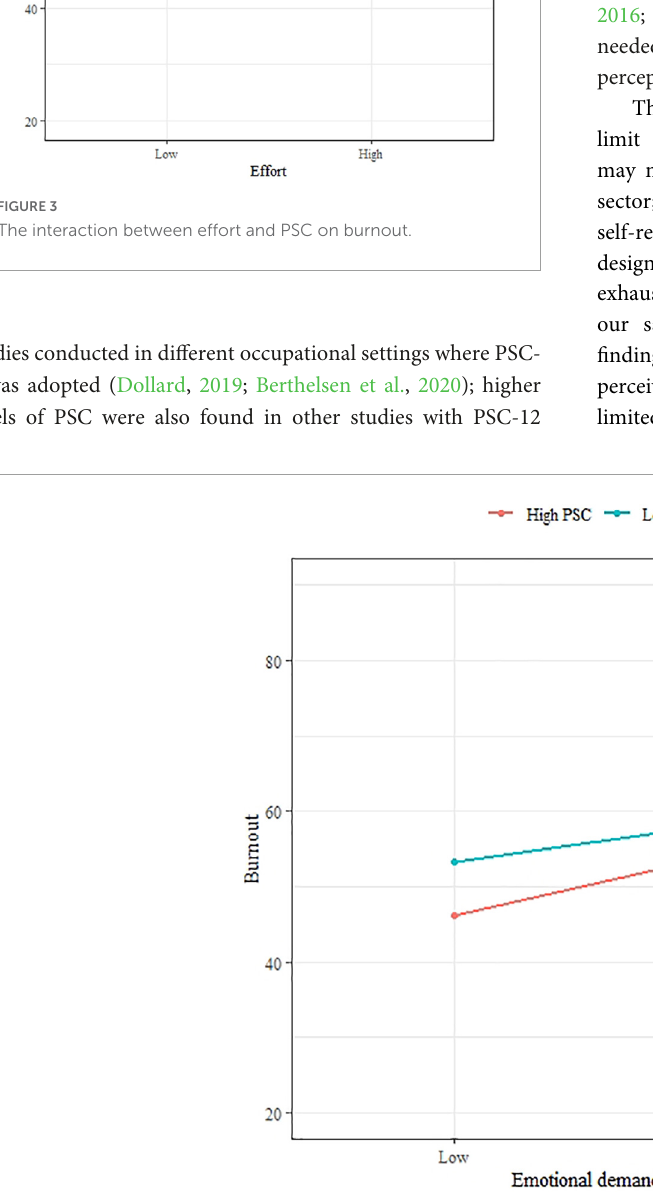
FIGURE4 The interaction between emotional demands and PSC on